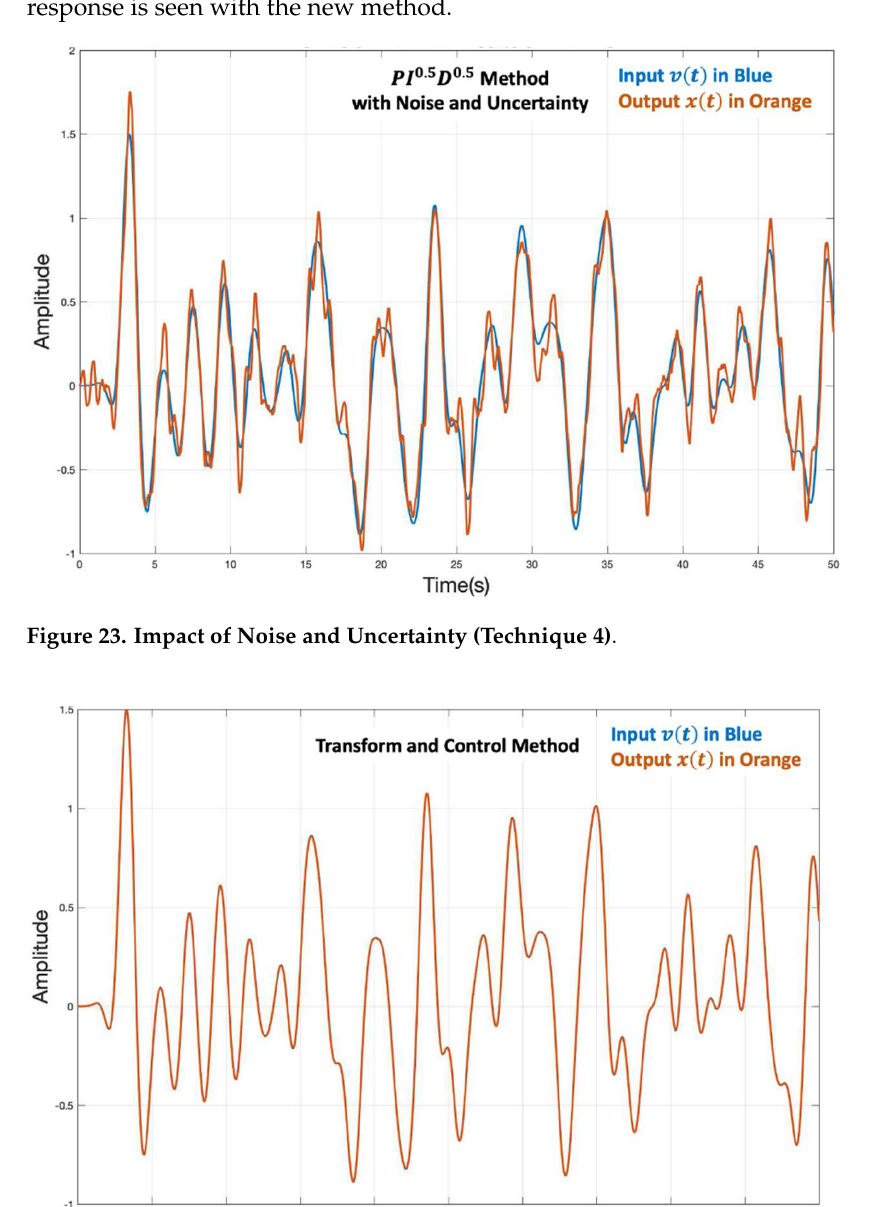
Figure 22. Impact of Noise on Control Performance (Technique 4).